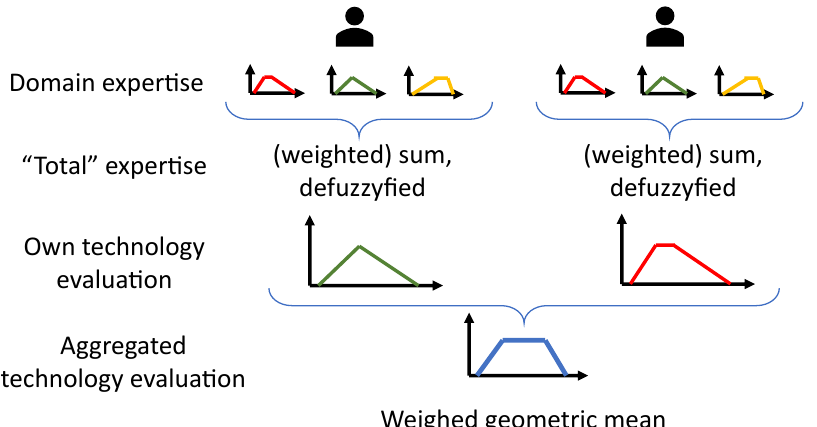
Figure 6. Schematic overview of expert weighting based on their self-determined expertise in relevant